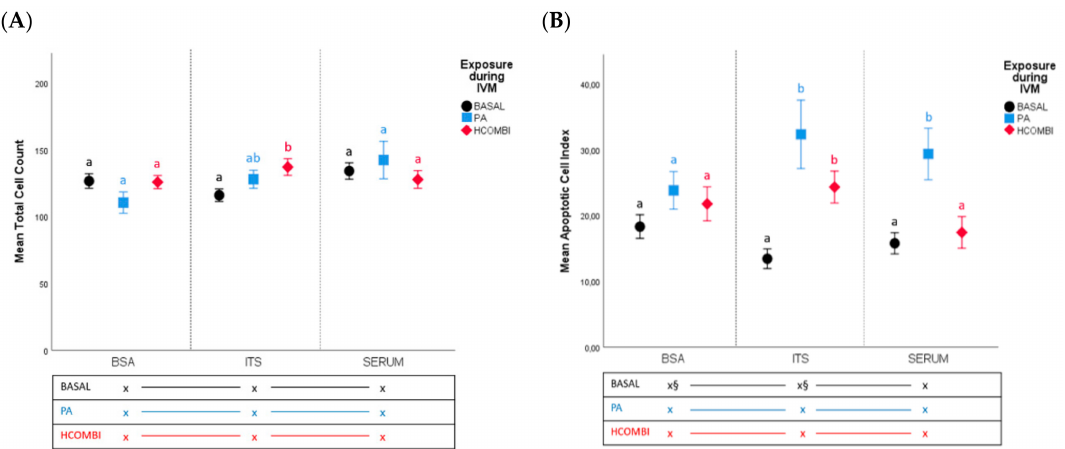
Figure 1. Mean total cell count ( A ) or apoptotic cell index ( B ) of Day 8 blastocysts resulting from oocytes exposed to BASAL (physiological NEFA concentrations), PA and HCOMBI NEFAs during maturation and cultured in the presence or absence of bovine serum albumin (BSA), ITS or serum. Data are presented as mean percentage ± SEM. Vertical superscripts (a, b) indicate significant di ff erences between maturation conditions within the same IVC condition ( p < 0.05). Horizontal superscripts (xindicate significant di ff erence between culture conditions within the same in vitro maturation (IVM) condition ( p < 0.05). Values labeled with “§” tend to be di ff erent from each other at p < 0.1 and >